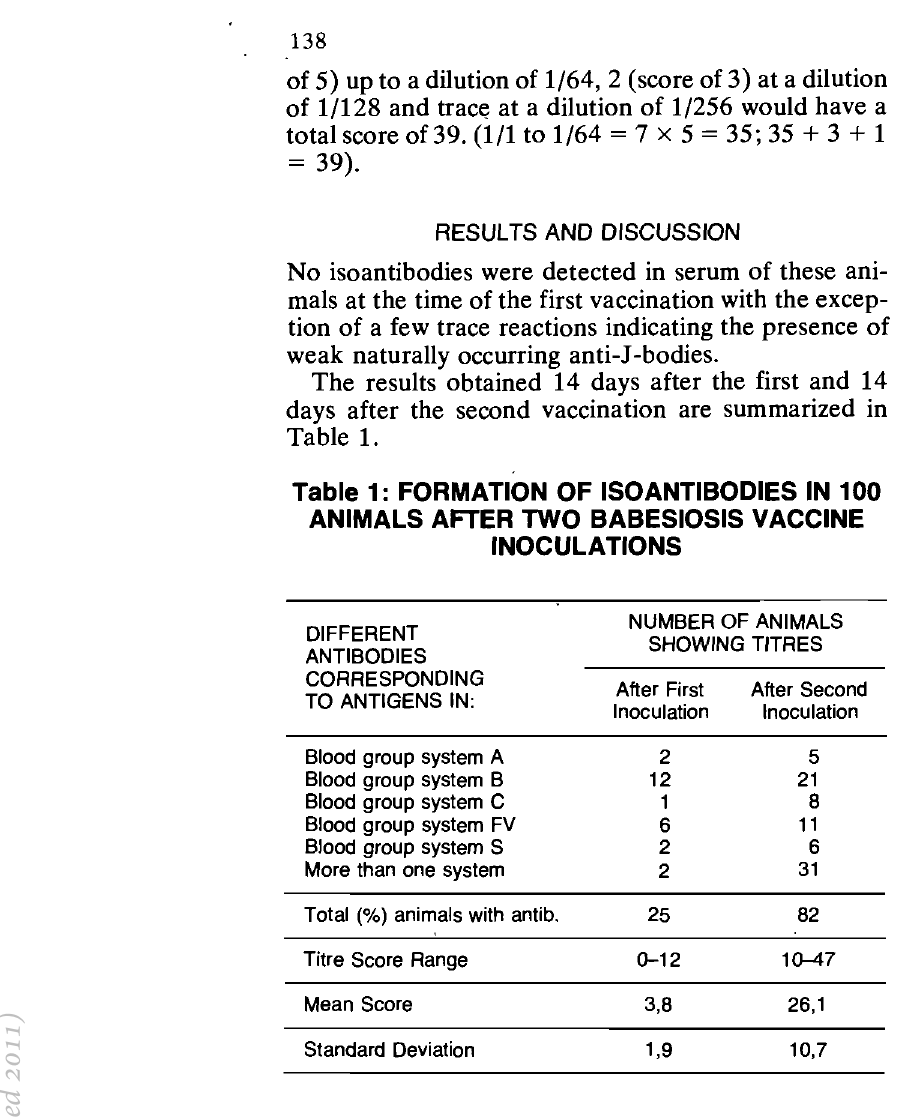
Table 1: FORMATION OF ISOANTIBODIES IN 100 ANIMALS AFTER TWO BABESIOSIS VACCINE INOCULATIONS NUMBER OF ANIMALS SHOWING